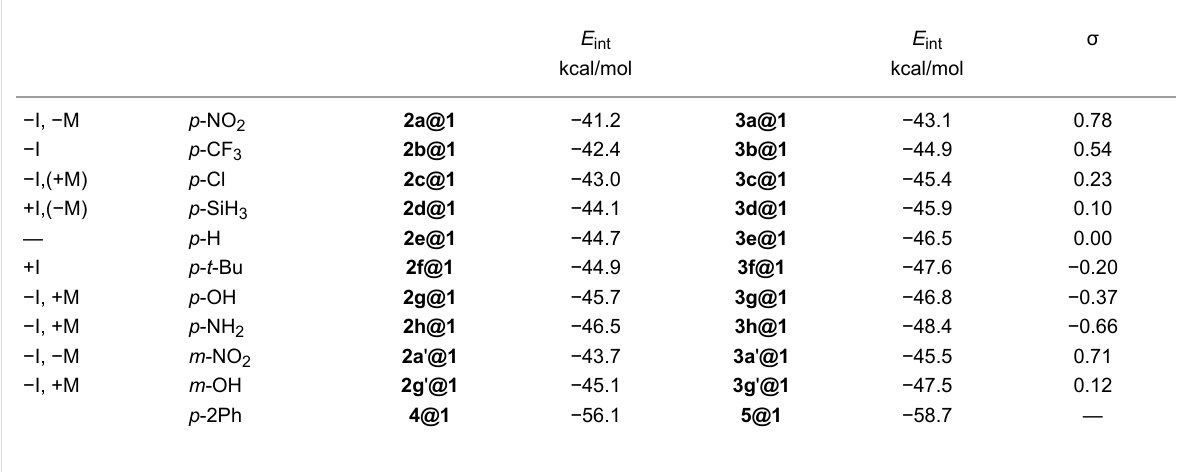
Table 2: Interaction energies E int for the different pseudorotaxane systems, labeling see Figure 1. The first two columns list the substituents succeeded by their effects (mesomeric or inductive). The last line gives the values for the di-phenyl structures. In the last column, the Hammett- parameters are